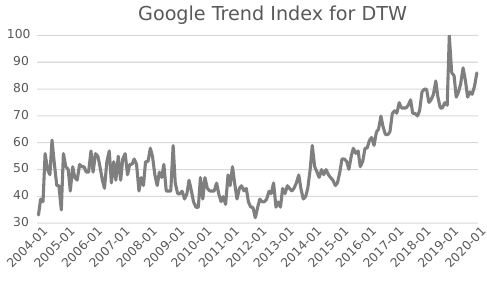
Figure 2. Google Trend Index for DTW from 2004 to 2020.